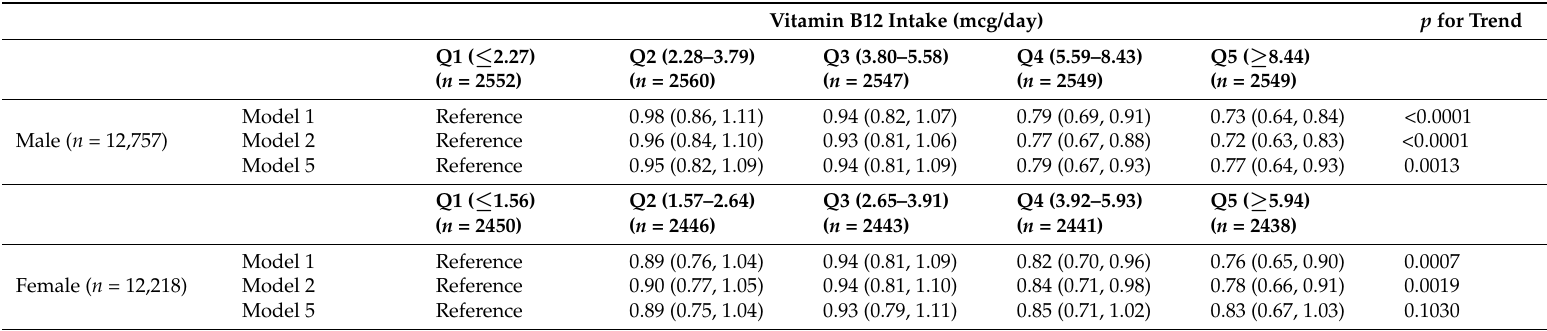
Table 6. Adjusted odds ratios of HU among participants associated with vitamin B12